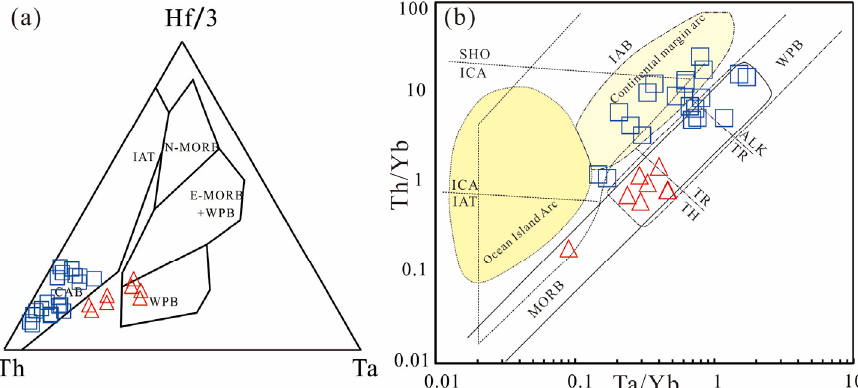
Figure 11. ( a ) Hf/3–Ta–Th diagram (modi fi ed from [76]); ( b ) Ta/Yb–Th/Yb diagram (modi fi ed from [65]). CAB: calc-alkaline basalt, WPB: within plate basalt, MORB: mid-ocean ridge basalt, IAT: island arc tholeiite, IAB: island arc basalt, ICA: island calcic alkali, SHO: Shoshone, TH: tholeiitic, TR: transition, ALK: alkali.